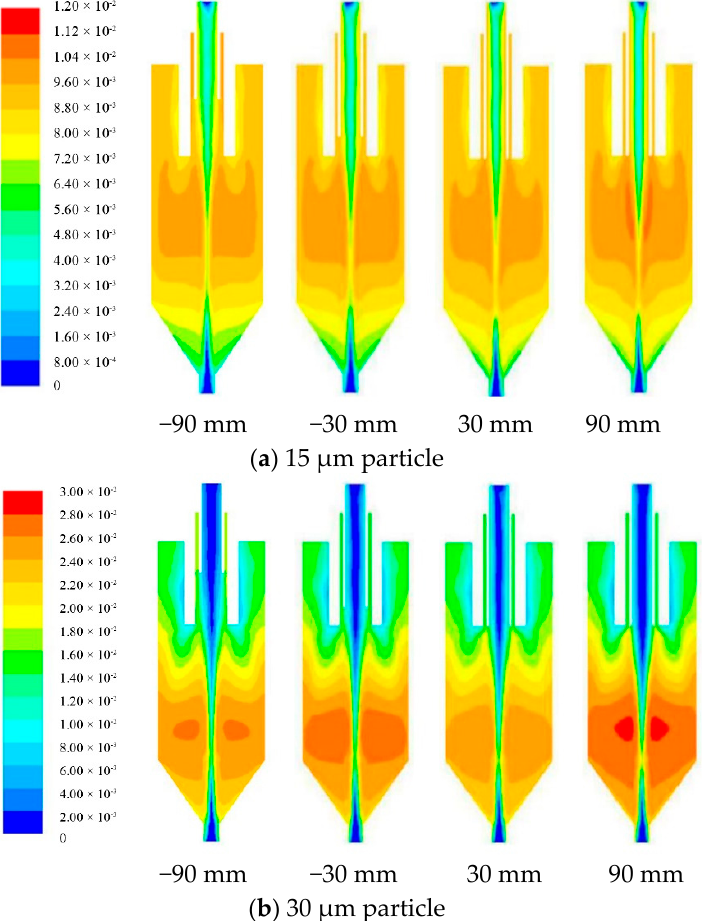
Figure 9. Particle distributions with different insertion depths of the inner vortex finders.